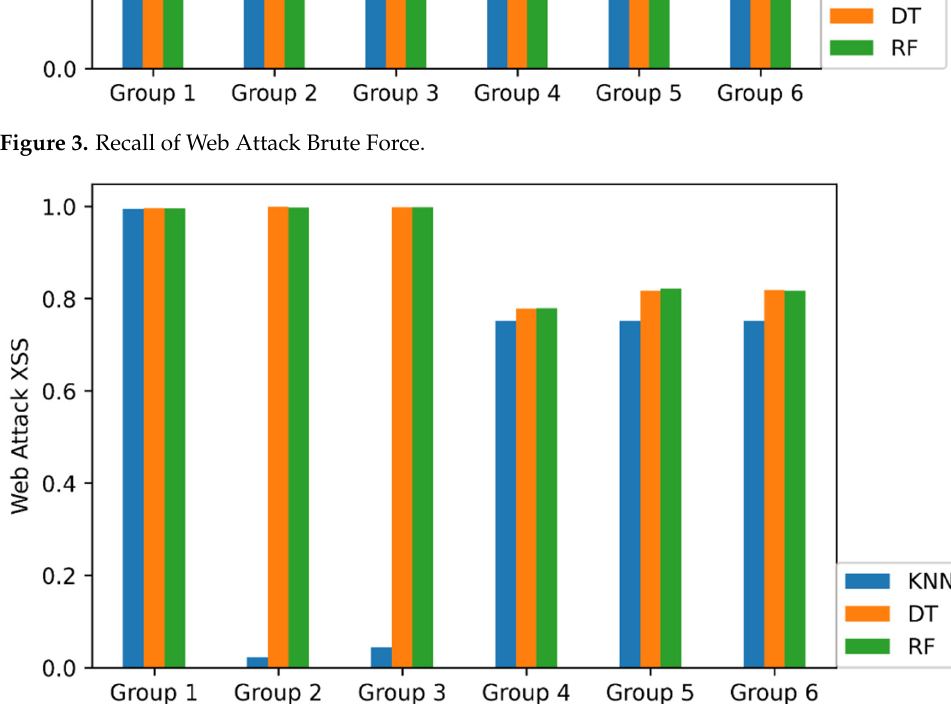
Figure 4. Recall of Web Attack XSS.